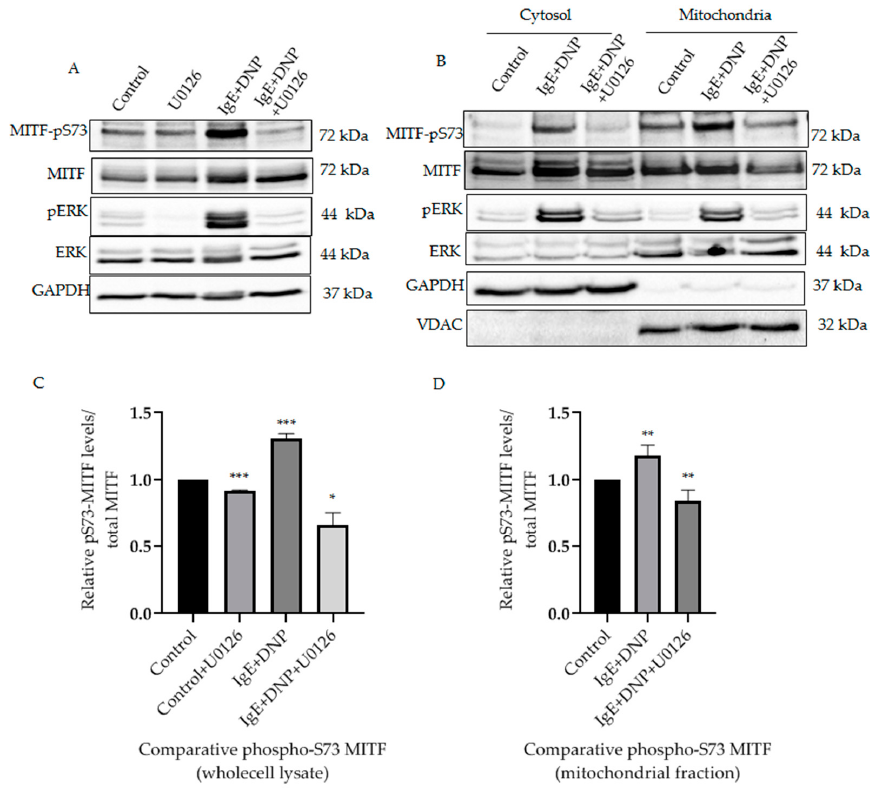
Figure 2. ERK1/2-dependent mitochondrial MITF Serine 73 phosphorylation in immunologically activated mast cells. ( A ), RBL cells were sensitized with 100 ng/mL IgE for 2 h, followed by a 15 min DNP challenge. Thirty minutes before the addition of DNP, 20 µ mol/L U0126 was added to the medium. The protein levels of MITF and ERK in the whole cell lysates were determined by Western blot analysis using anti-pS73-MITF, anti-MITF, anti-pERK, anti-ERK and anti-GAPDH antibodies. ( B ), RBL cells were treated as in ( A ). The cells were fractionated into cytosol and mitochon- dria. The protein levels of MITF in both fractions were determined by Western blot analysis using anti-pS73-MITF, anti-MITF, anti-pERK, anti-ERK, anti-GAPDH (cytosolic marker) and anti-VDAC (mitochondrial marker) antibodies. ( C , D ), Densitometry of MITF-pS73/total MITF levels in RBL cells wholecell lysate ( C ) and mitochondrial fractions ( D ) that were treated with U0126 and DMSO as control as in ( A ). A two-tailed Student t -test was performed for all the western blots. Results represent means ± SEMs (n = 4, *** p ≤ 0.001; ** p ≤ 0.01; * p ≤ 0.05; ns p >